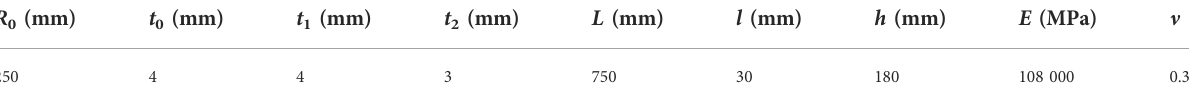
TABLE 1 Model 1 parameter setting.